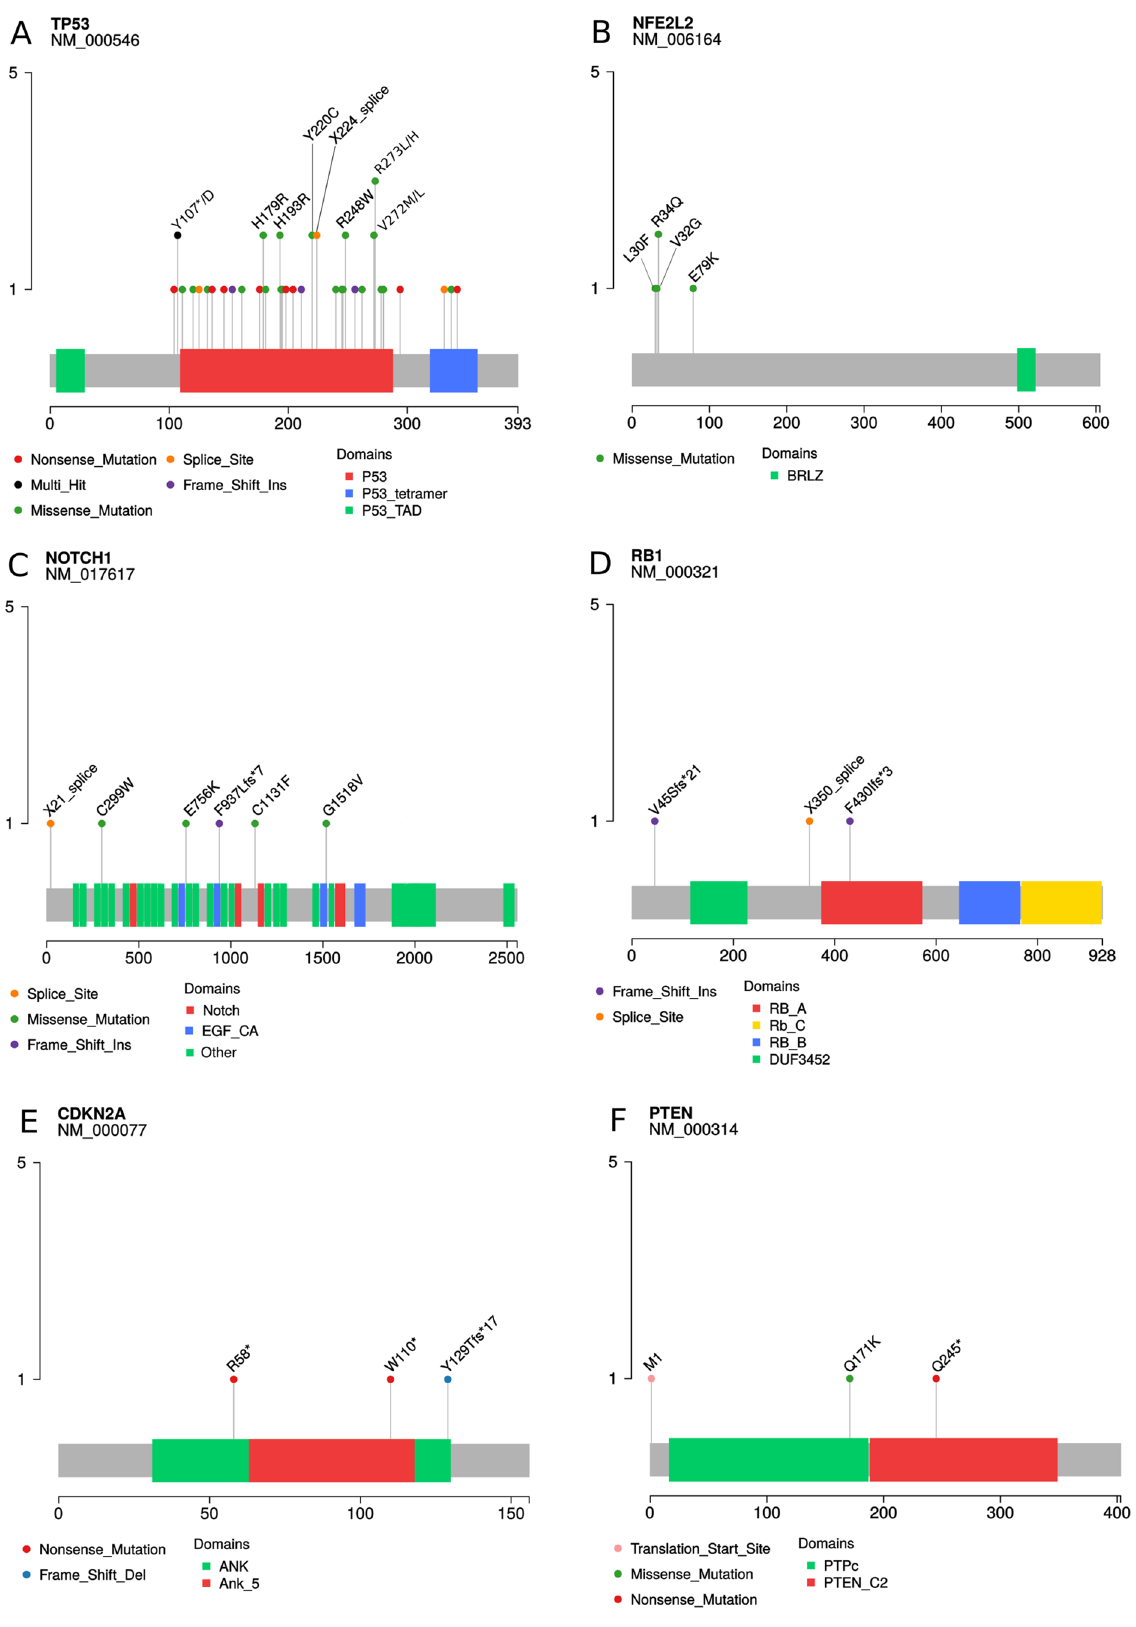
Figure 2. Lollipop plot of the genes with the highest frequency of